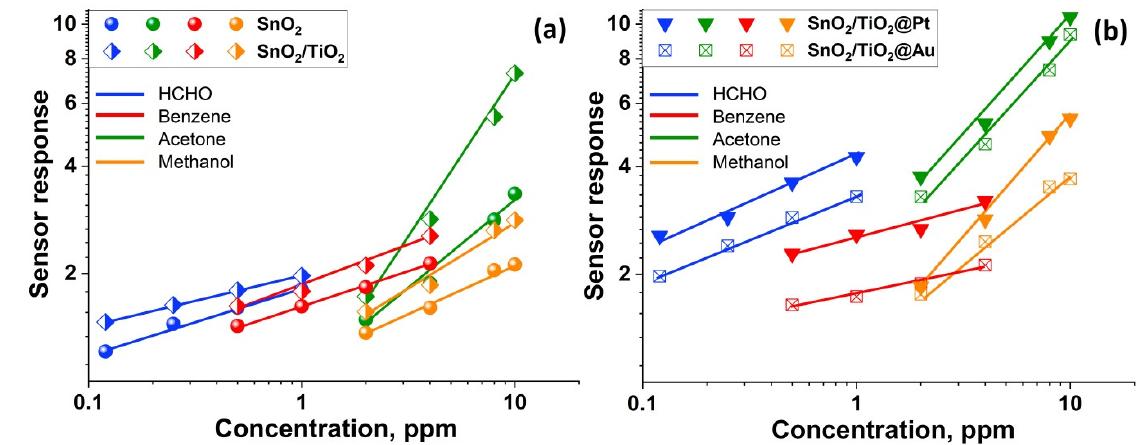
Figure 9. Cross sensitivity of SnO 2 , SnO 2 /TiO 2 ( a ) and SnO 2 /TiO 2 @Pt, SnO 2 /TiO 2 @Au ( b ) samples toward HCHO (blue), benzene (red), acetone (green) and methanol (orange) at 200 °C.